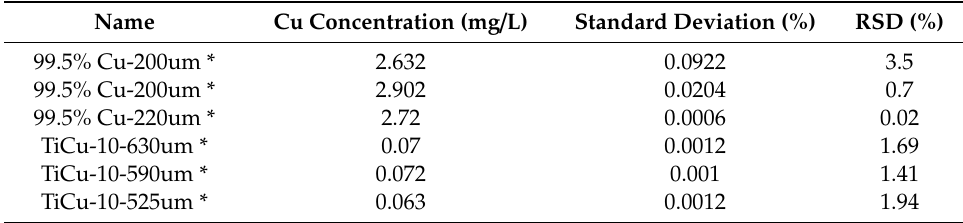
Table 2. Cu ion concentration together with standard deviation (SD) and relative standard deviation (RSD) for the measurement made on each token. Note that ‘*’ denotes the thickness of the